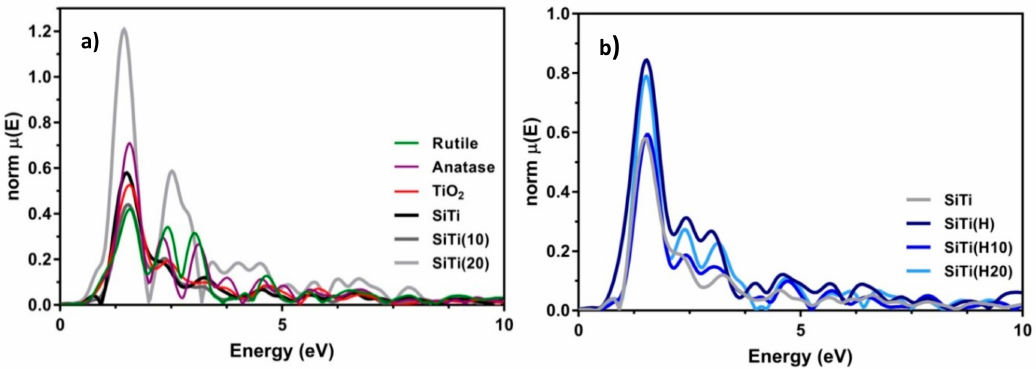
Figure 7. Ti K-edge EXAFS spectra of FSP-synthesized SiTi ( a ) before and ( b ) after hydrogenation and plasma treatment. Pure anatase, rutile, and FSP-prepared TiO 2 controls are also